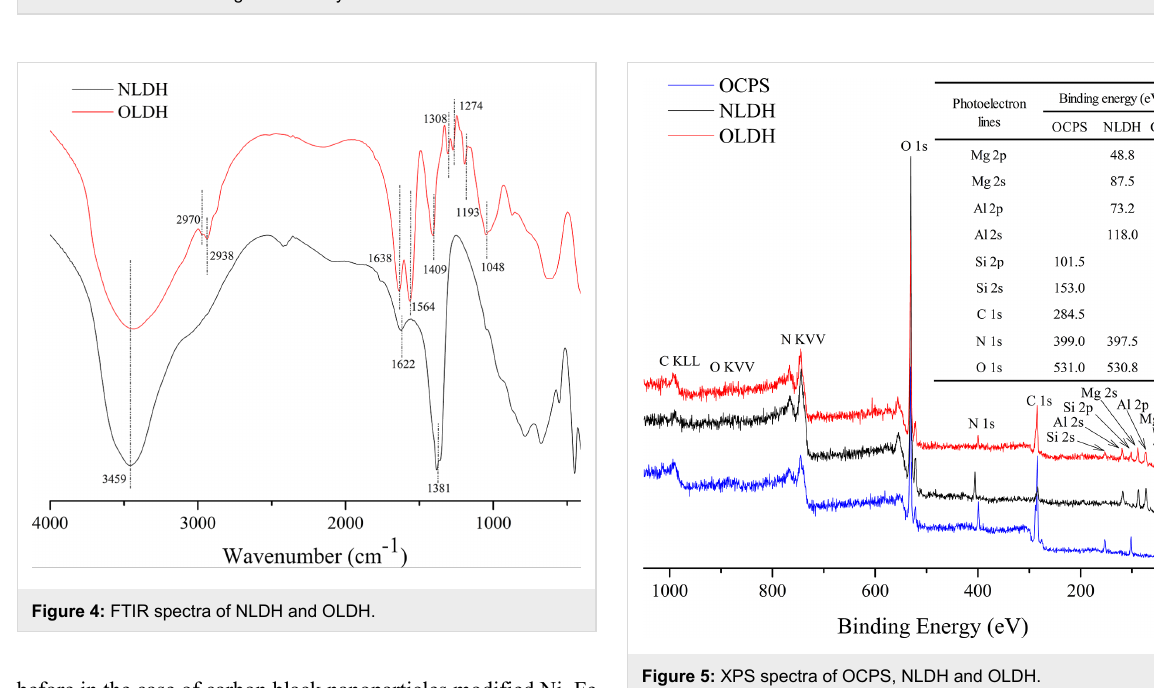
before in the case of carbon black nanoparticles modified Ni–Fe LDH [31].